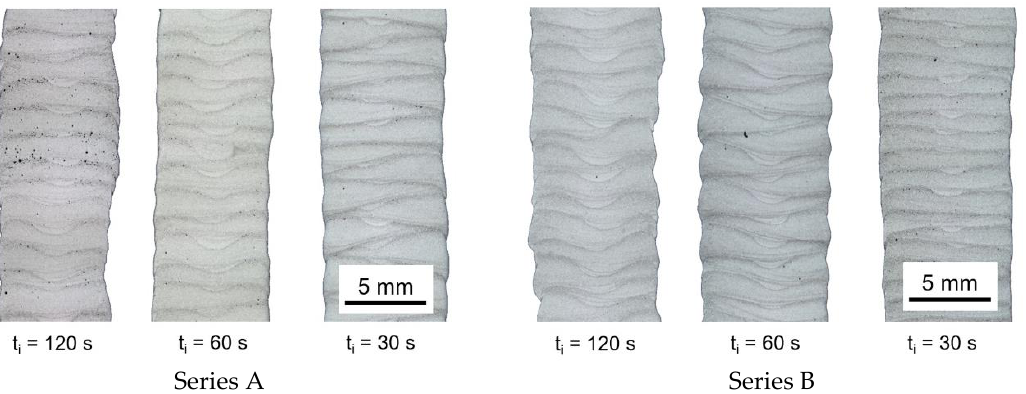
Figure 5. Cross-section micrographs of wire and arc additive manufacturing (WAAM) samples with varying process strategies.